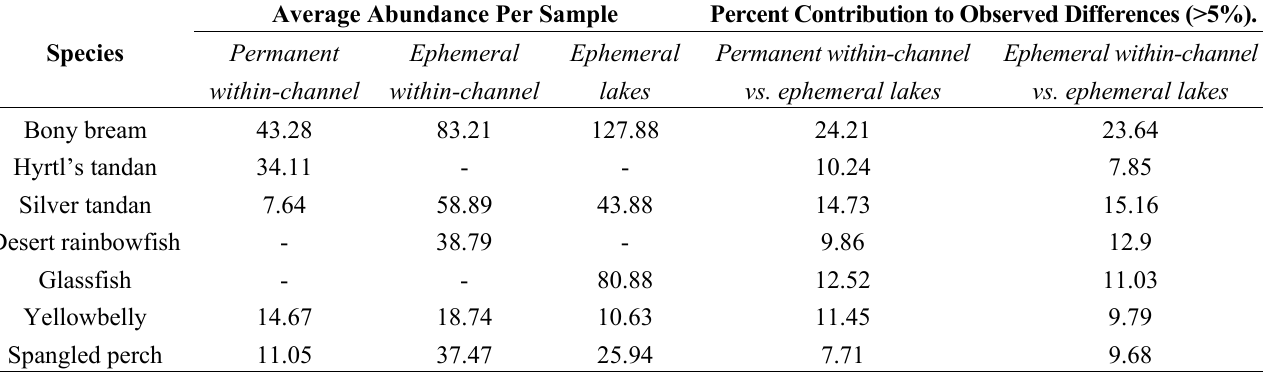
Table 4. SIMPER analysis comparing fish species presence/absence in relation to waterhole type in the Queensland Lake Eyre Basin from April 2007–March/April 2008. (Permanent within-channel waterholes = no drying within the study period, ephemeral within-channel waterholes = at least one drying event during the study period, ephemeral lakes = floodplain lakes that dried at least once during the study